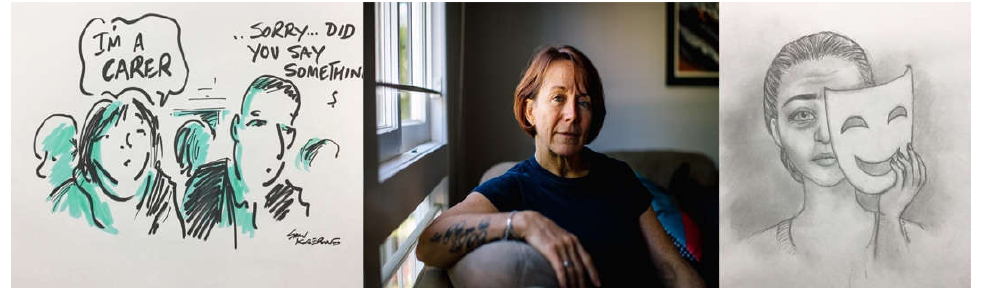
Figure 5. The face of carers, who often felt alone and unsupported. Carers explained that “ grief is messy.. there is a lot of snot and tears ”. The poems and creative images very emotively convey the pain of caring for, losing, and missing a loved one. As well as caring for her husband before he died, Dianne relocated cities for several months, to care for her best friend when she was dying from cancer. She held her hand and slept beside her during these last few weeks, as we see in the professional pictures in Figure 6. The deaths of two loved ones in 12 months had broken Dianne, who explained that “I will never, ever—I don’t ever want to love anyone again. Because to lose them is so …… heartbreaking. All I remember is the sadness. It was just 12 months of absolute sadness and misery”. Figure 7 illustrates a particularly challenging transition for carers: when home became a hospital, and the bed is no longer a place of rest and refuge, but a site of medical intervention. The sketch on the left shows a normal bedroom; the right side, the same bed with hospital equipment. The other sketch is of a memory; one carer explained how she could still sense her love husband in his beloved chair at home, with this sketch showing his ghostly form in his seat.